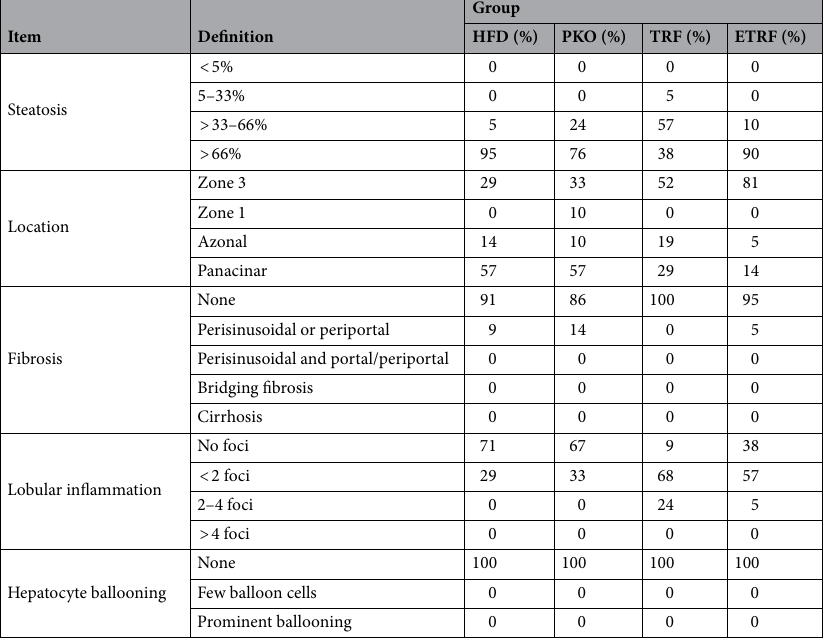
Table 7. Assessment of NAFLD activity score (NAS).